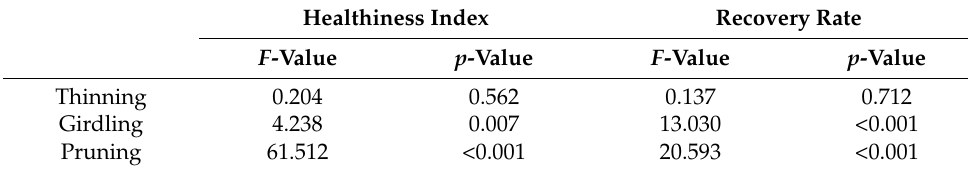
Figure 3. Treatment effects of girdling, thinning and pruning on healthiness index ( A ) and recovery